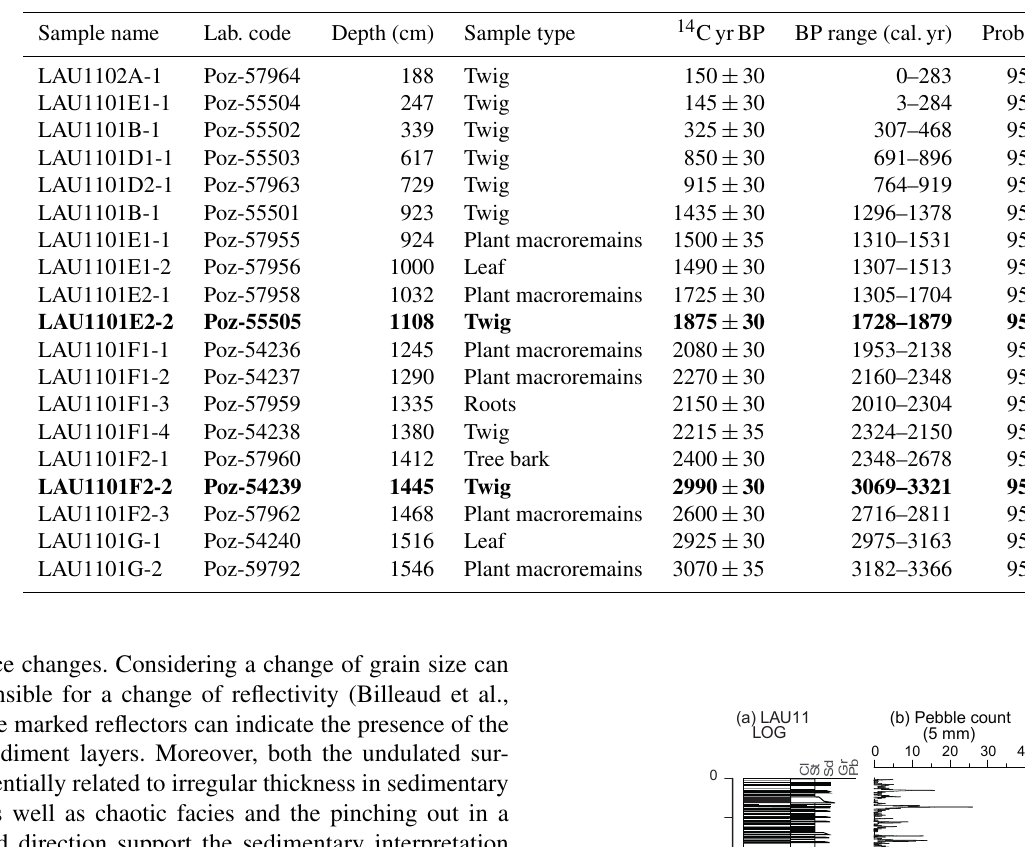
Table 1. Radiocarbon ages for LAU11 sediment sequence. Bold samples are excluded dates in the age model.